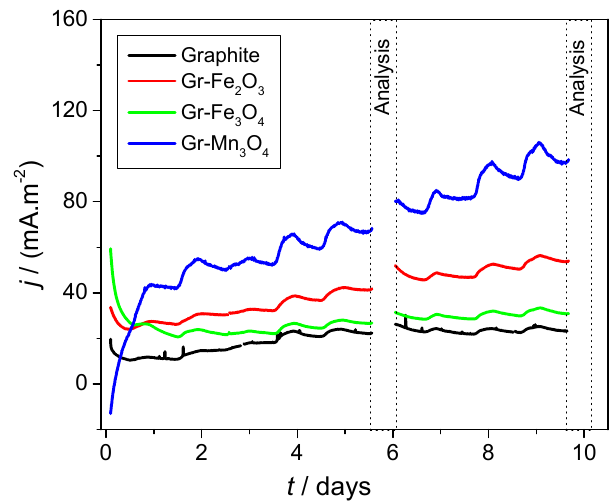
Figure 4. Current density obtained with Gr–Fe 2 O 3 , Gr–Fe 3 O 4 , Gr–Mn 3 O 4 , and bare graphite at continuously applied potential of +0.2 V (vs. Ag/AgCl) in the presence of P. putida 1046.